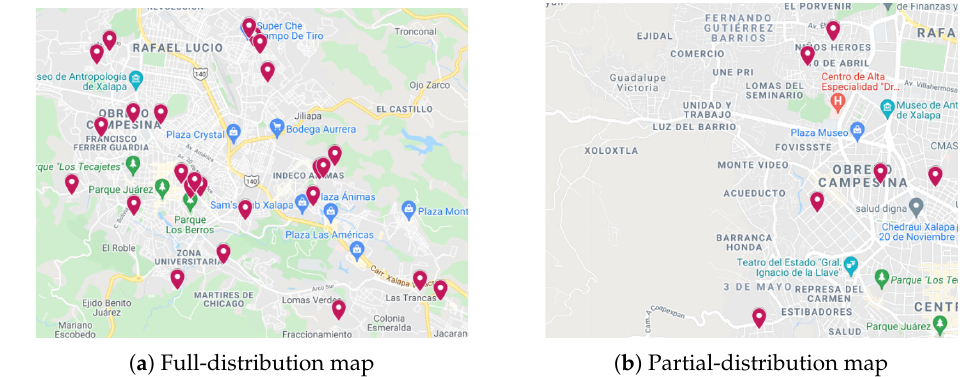
Figure 13. Distribution of deliveries in the city of Xalapa.